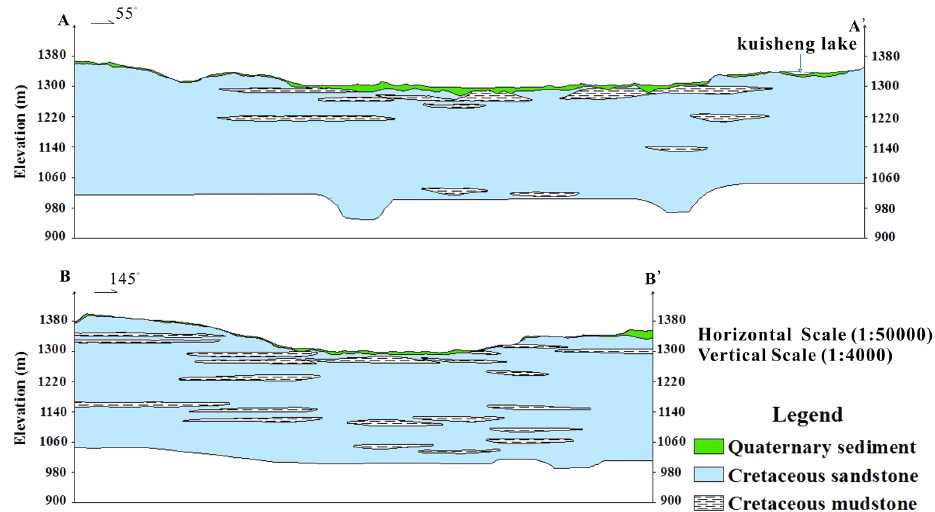
Figure 4. Geologic sections of the study area. Data were revised from original source (Inner Mongolia Second Hydrogeology Engineering Geological Prospecting Institute,